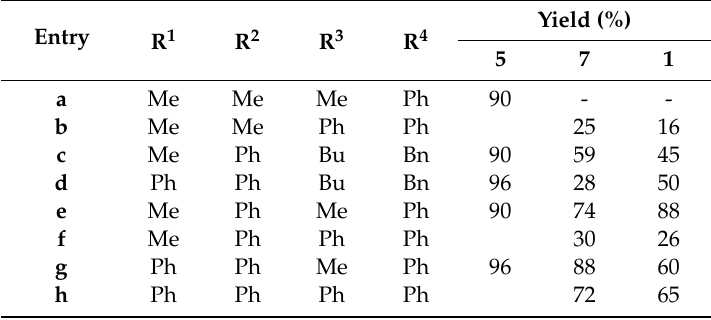
Table 1. Synthesis of 2-diazo-2-sulfamoylacetamides